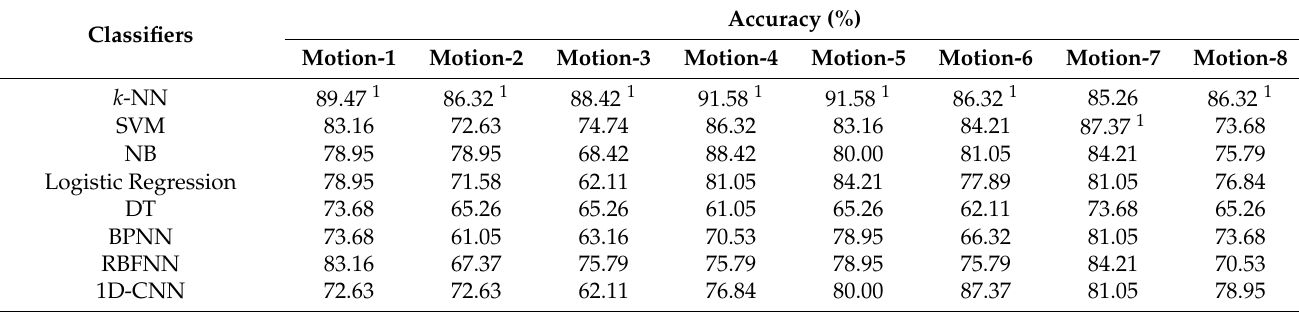
Table 4. Accuracy of motion assessment of different classifiers, using scores from Teacher